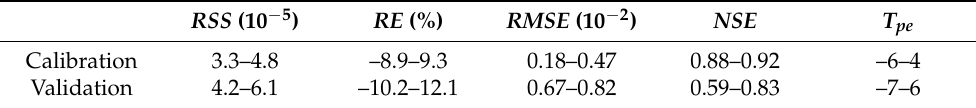
Table 3. Summary of the model evaluation indicators in calibrating and validating